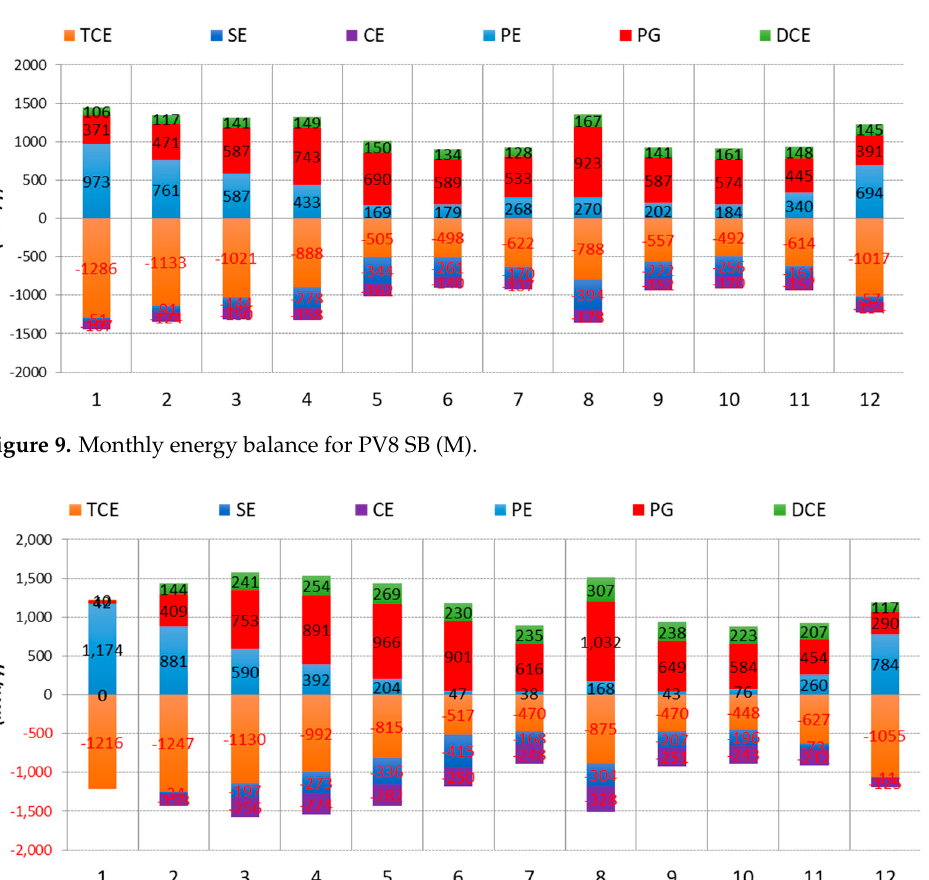
Figure 10. Monthly energy balance for PV8 SB (L).